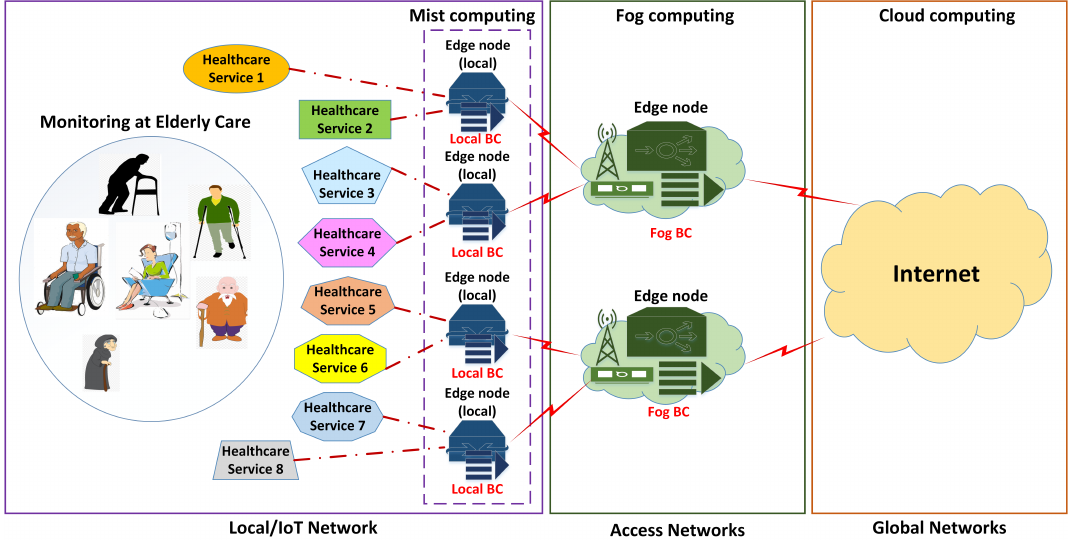
Figure 2. Blockchain-Edge framework for remote elderly healthcare monitoring. The resource-constrained medical nodes at the local tier are connected to the higher ca- pacity computational nodes (local edge nodes) for local data processing, analysis, decision- making, and forwarding the information/data further to the edge or the global